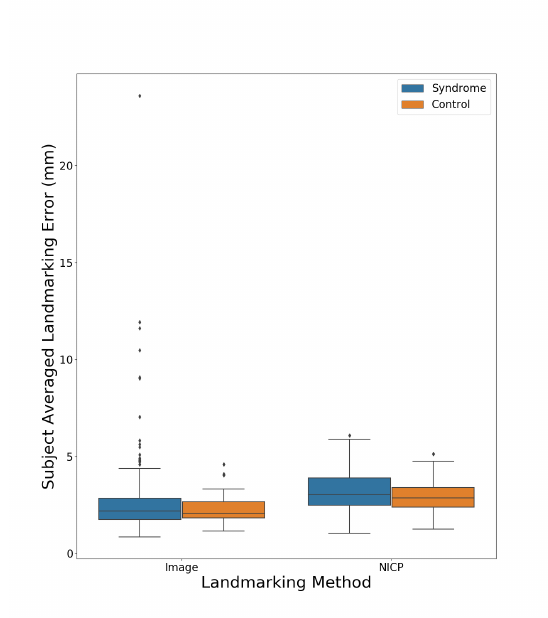
Figure 7. The subject averaged landmark errors for both the NICP and image-based landmarking methods separated by syndrome diagnosis.